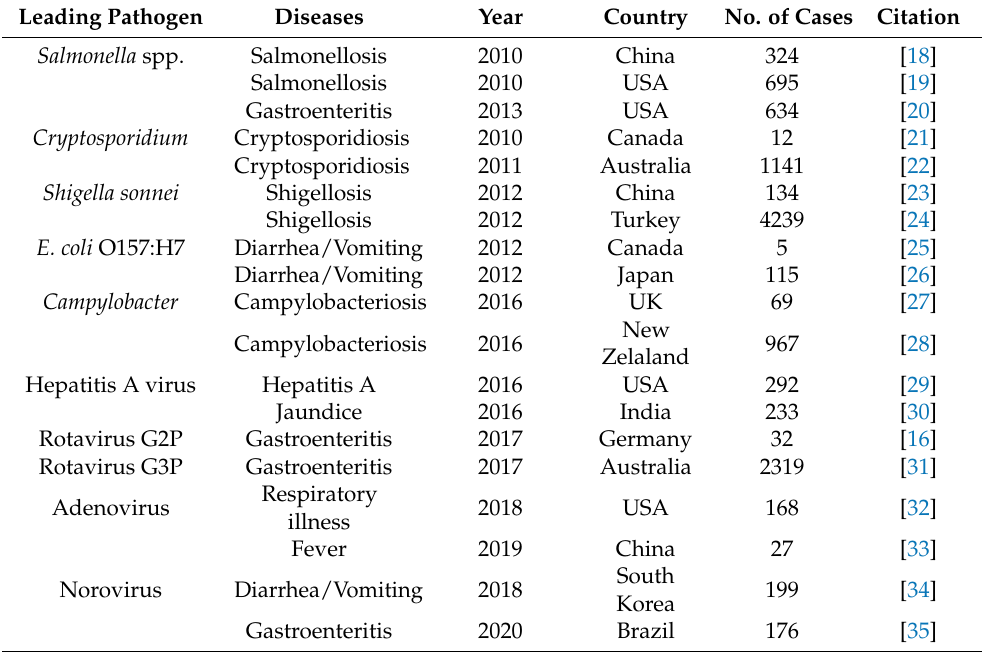
Table 1. Examples of outbreaks of waterborne and foodborne diseases from 2011 to